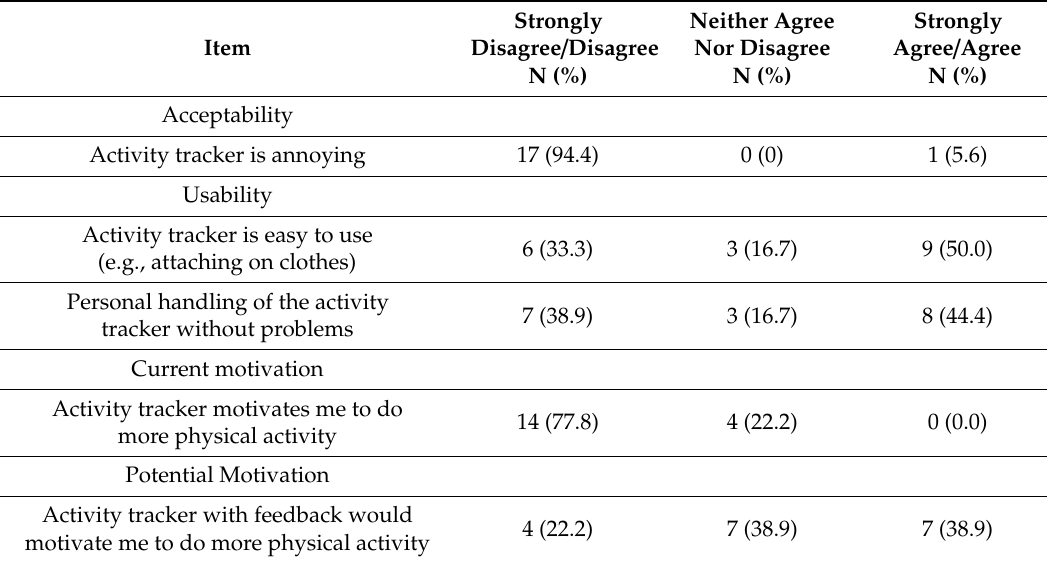
Table 7. Acceptability, usability, motivational capability of Fitbit